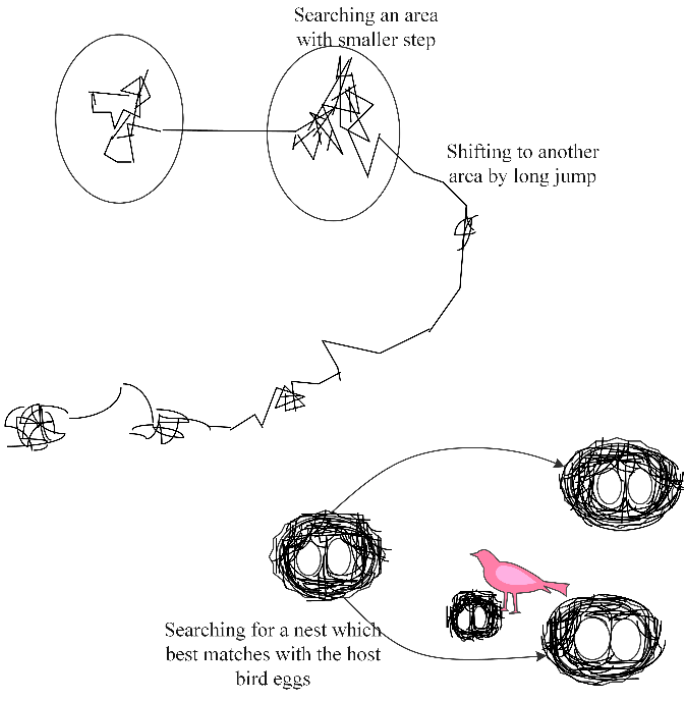
Figure 5 . Working of cuckoo search . Figure 5. Working of cuckoo search.